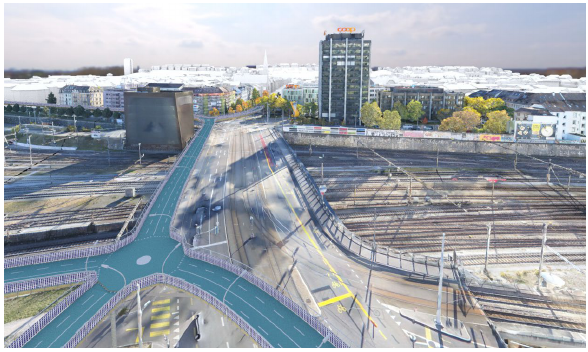
Figure 1. Reality-based 3D urban scene automatically reconstructed from MMS and UAV imagery with augmentation of planned bike highway.